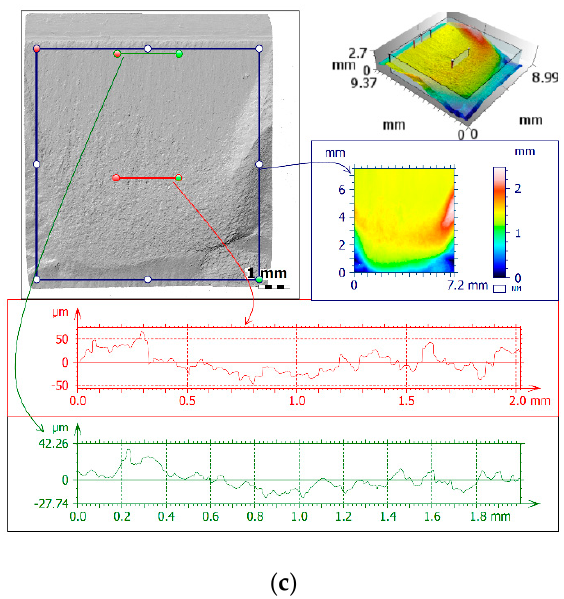
Figure 7. Fractures with marked crack propagation profile (green), rupture roughness profile (red), and extracted total area for exemplary specimens made of: ( a ) 10HNAP steel; ( b ) S355J2 steel; and ( c ) AW-2017A-T4 aluminium alloy.